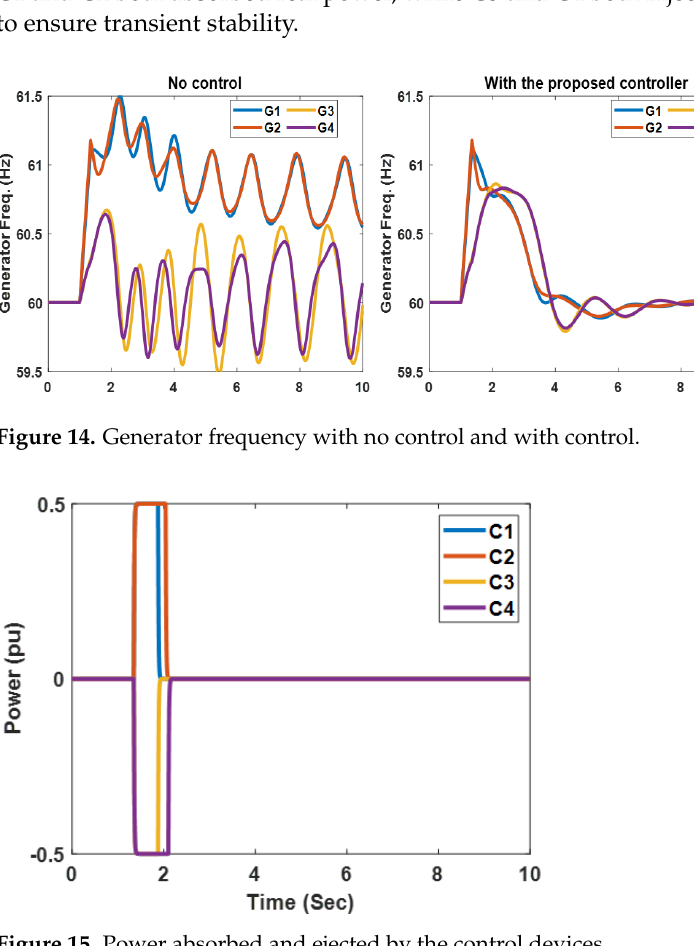
Figure 15. Power absorbed and ejected by the control